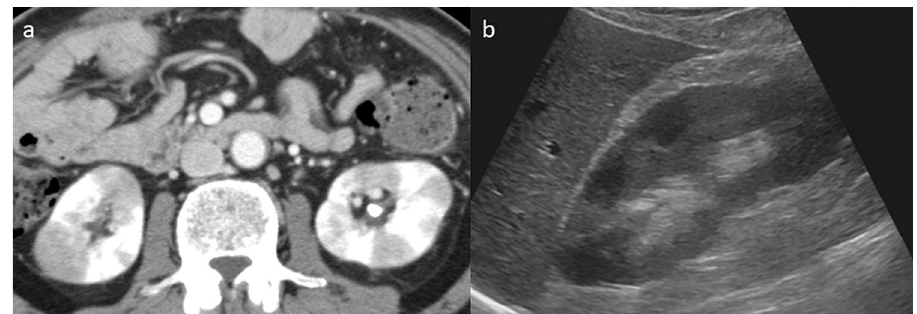
Figure 2. Comparison of the radiological findings of renal lesions between contrast-enhanced CT and transabdominal ultrasound in a patient with AIP. (a) A contrast-enhanced CT showing multiple hypodense lesions in both kidneys. (b) Transabdominal ultrasound showing multiple ill-defined, non-mass-like areas with decreased echogenicity in the right